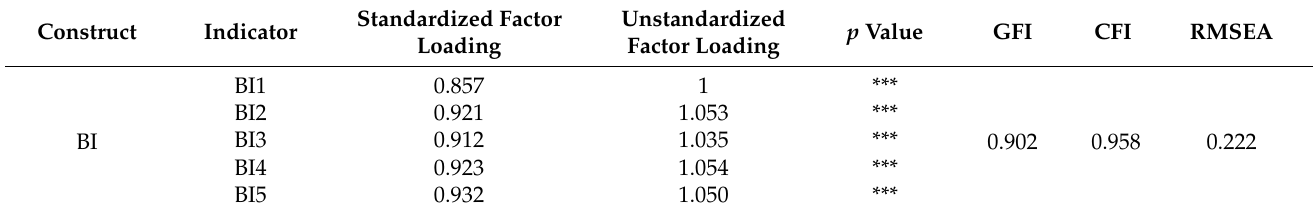
Table 4. CFA analysis for behavioral intention to use.